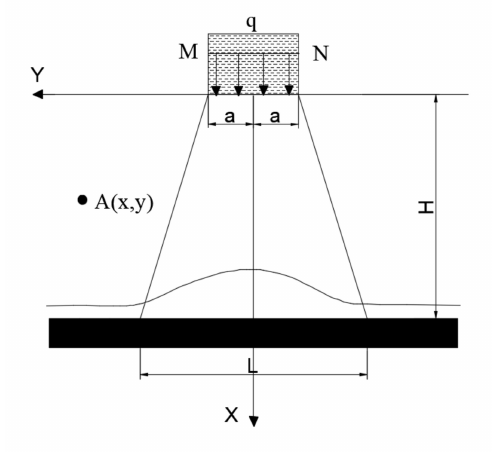
Figure 8. Stress transfer diagram of the coal